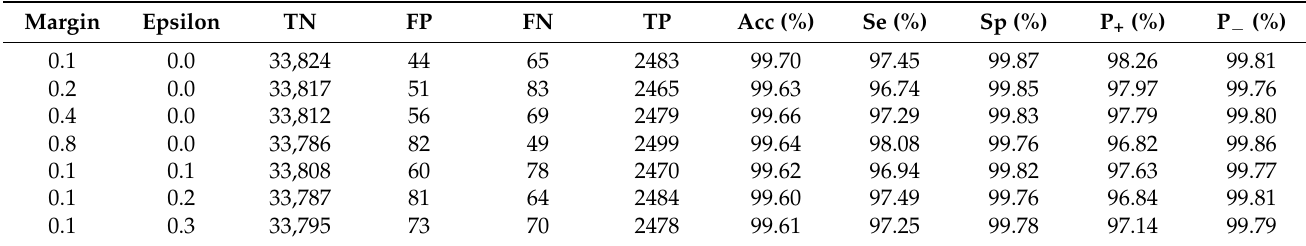
Table 11. The experiment results about the margin and